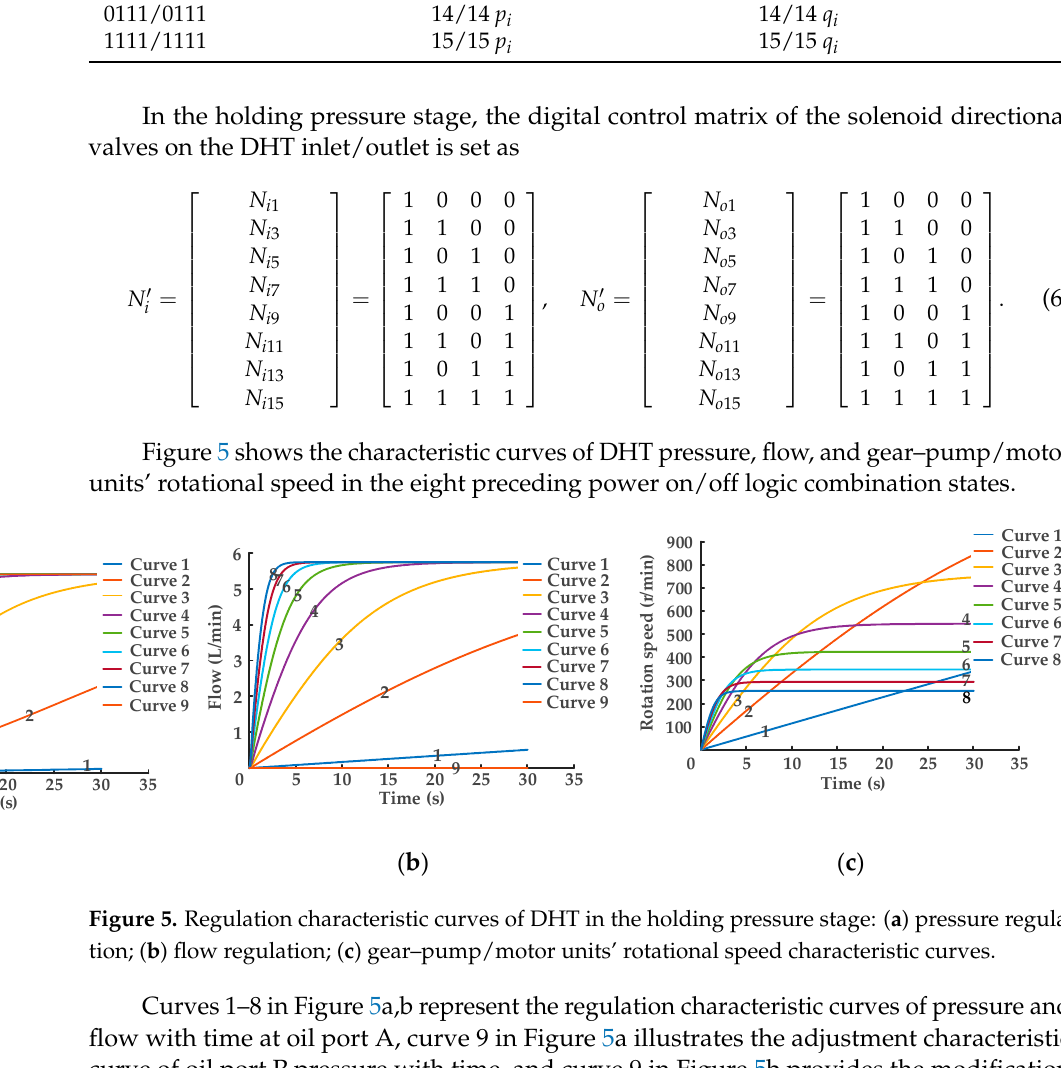
Table 2. Fifteen logic combinations with a pressure transformation ratio of 1.